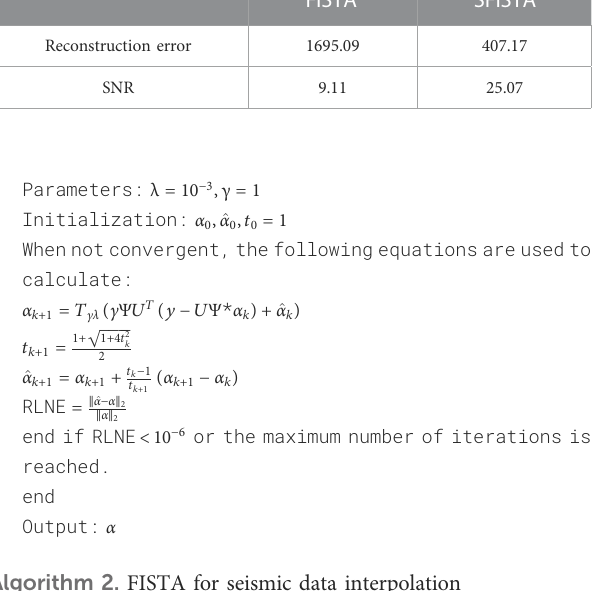
Algorithm 2. FISTA for seismic data interpolation